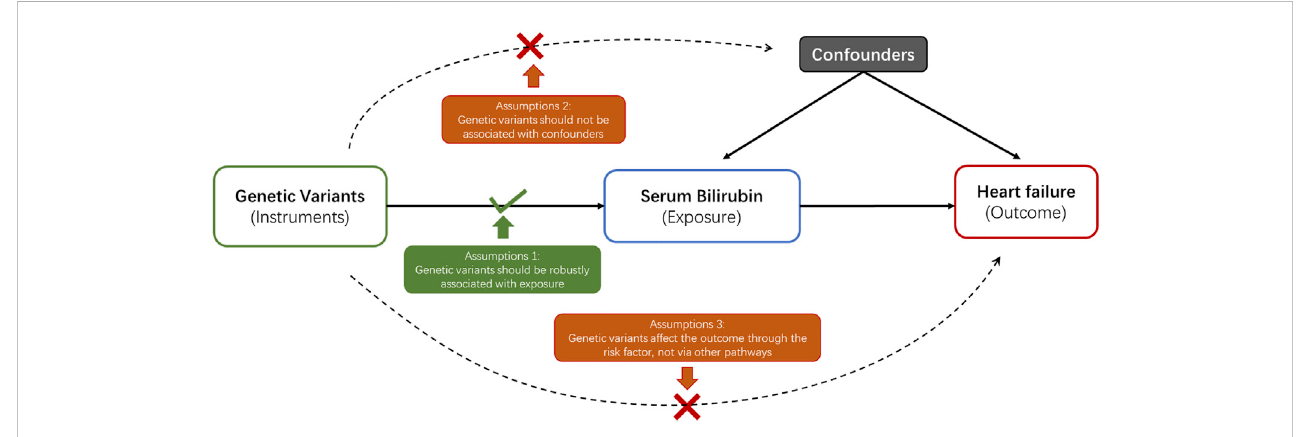
FIGURE 1 Three key assumptions underlying the Mendelian Randomization study